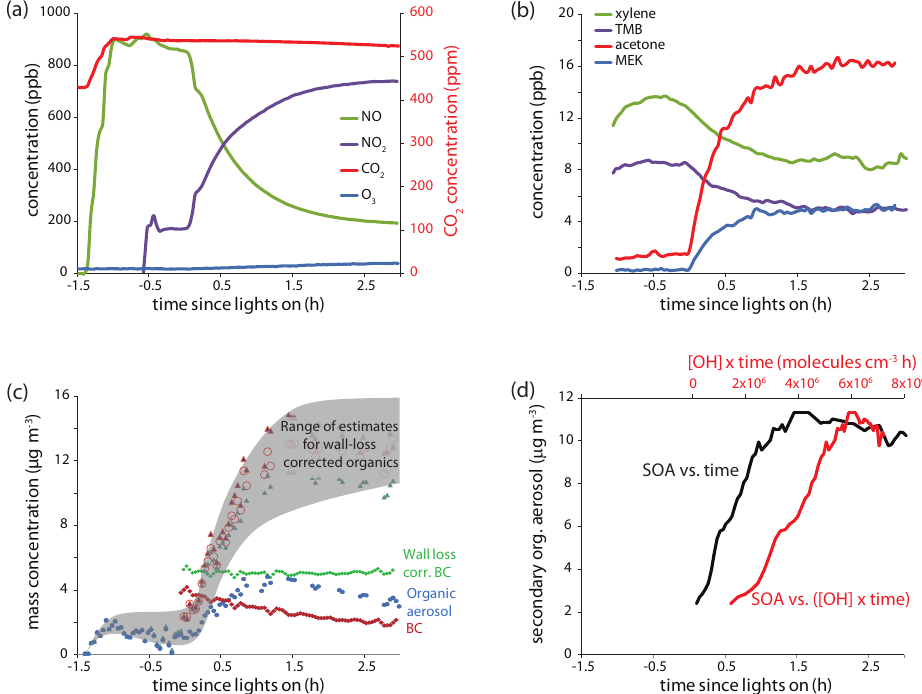
Fig. 4. Measured gas and particle evolution during a typical smog chamber experiment (LEV1-6.2 experiment): (a) NO x , O 3 and CO 2 ; (b) selected primary (xylene and trimethylbenzene, TMB) and secondary (acetone and methyl ethyl ketone, MEK) organic gases; (c) mea- sured and wall-loss-corrected black carbon (BC) and organic aerosol concentrations; and (d) wall-loss-corrected SOA production (average of two correction methods) as a function of time (black, lower x axis) and OH exposure (red, upper x axis). Within the range of − 1.5h < time < − 1.0h, the chamber was filled with diluted emissions from the vehicle; for − 1.0h < time < 0h, the primary PM was characterized; at time > 0 h the UV lights were on and photooxidation generated SOA. The grey shaded area in (c) indicates the range of wall-loss correction estimates discussed in the text. A four-period moving average is used to smooth both data sets in (d)